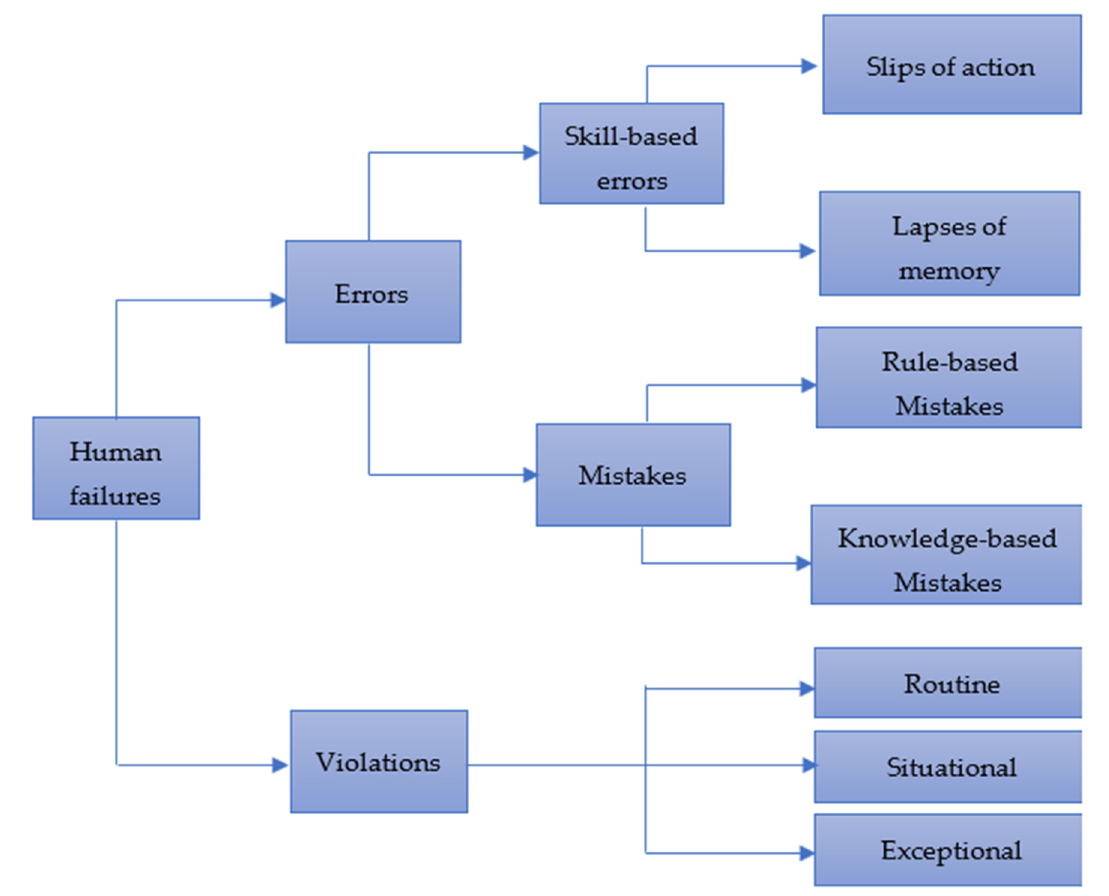
Figure 13. Different types of Human Failures.